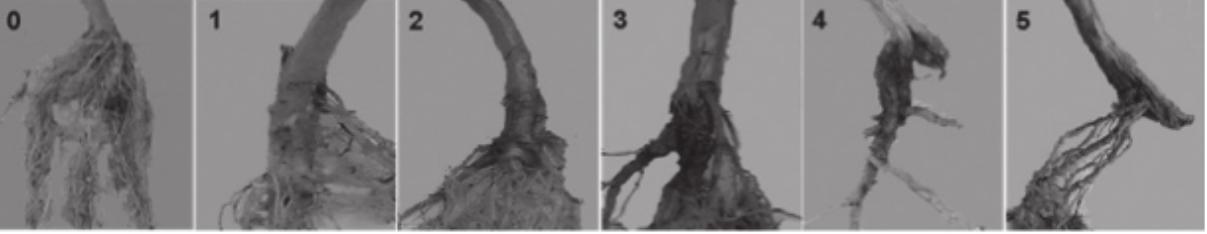
Figure 1. Representative symptoms on melon crown, primary and secondary roots upon artificial inoculation with Monosporascus cannonballus rated on a scale of severity: 0, healthy; 1, 25% root surface with lesions; 2, 50% root surface with lesions; 3, 75% root surface with lesions; 4, roots with very extensive lesions; 5, roots badly